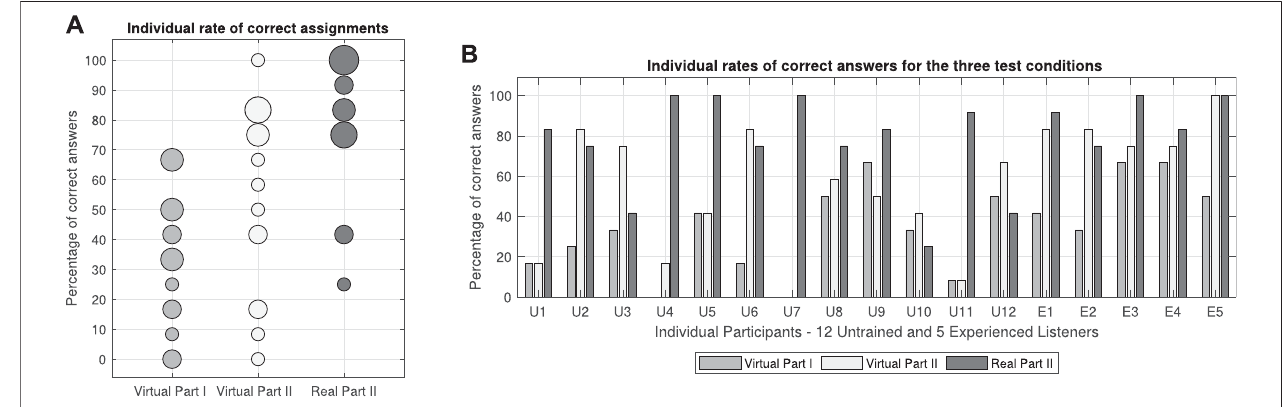
FIGURE 4 | (A) Individual rates of correct answers sorted by test condition. The size of the bubbles indicates how many subjects achieved this result. (B) Percentage ofcorrectanswersachievedbythe17individualparticipantsforthesceneswiththevirtualreproductioninpart Iandpart IIoftheexperimentandthereal source in part